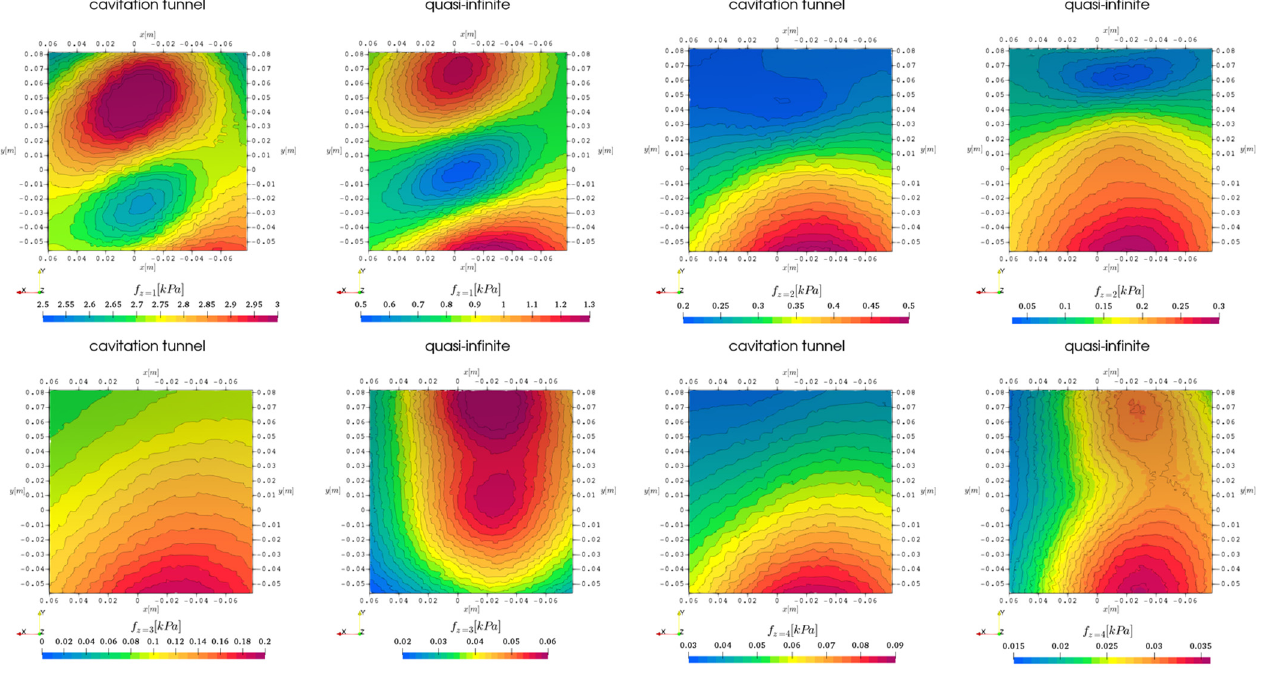
Figure 5. First 4 harmonic propeller blade frequencies incompressible hull pressure above propeller, comparison of domain extent, LES with cavitation.